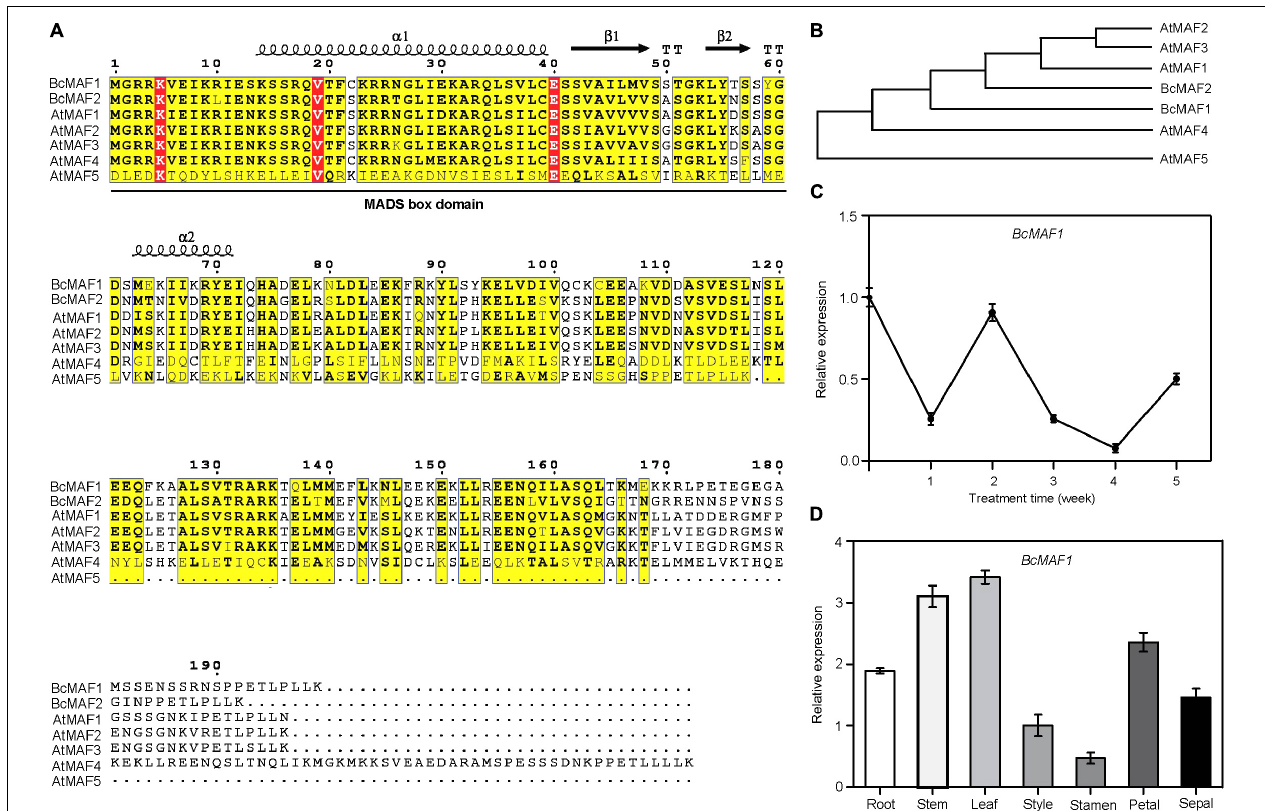
FIGURE 1 | BcMAF1 is a short-term cold response gene encoding an MADS protein. (A) Sequence alignment of BcMAF1, BcMAF2, and AtMAFs. Conserved and similar residues are boxed with red and yellow, respectively. The MADS-box domain is indicated by a straight line. (B) The phylogenic tree of BcMAF1, BcMAF2, and AtMAFs. The gene accession numbers are as follows: AtMAF1 (AT1G77080), AtMAF2 (AT5G65050), AtMAF3 (AT5G65060), AtMAF4 (AT5G65070), AtMAF1 (AT5G65080), BcMAF1 (MG964044), and BcMAF2 (MG964045). (C) The expression of BcMAF1 during the process of vernalization in Pak-choi by qPCR. (D) The expression of BcMAF1 in different tissues of Pak-choi by qPCR. Data shown are means ± SEM of three independent